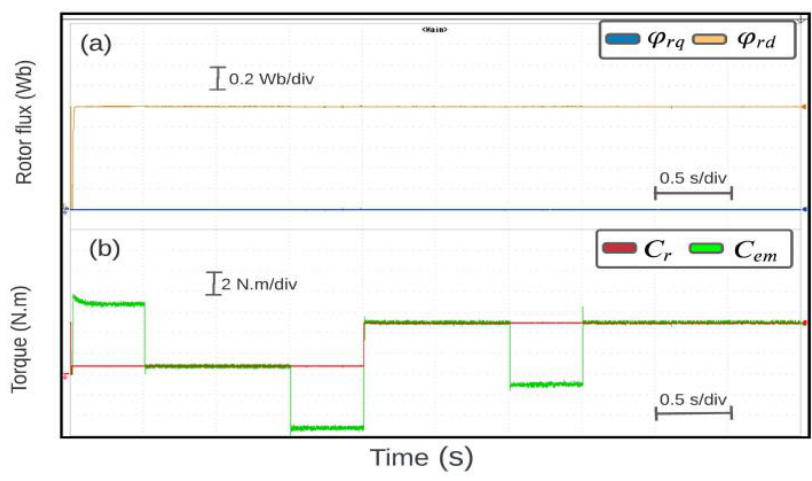
Figure 10. OeW-5PIM performance during high-speed reverse ( a ) d-q rotor flux responses; ( b ) developed torque.